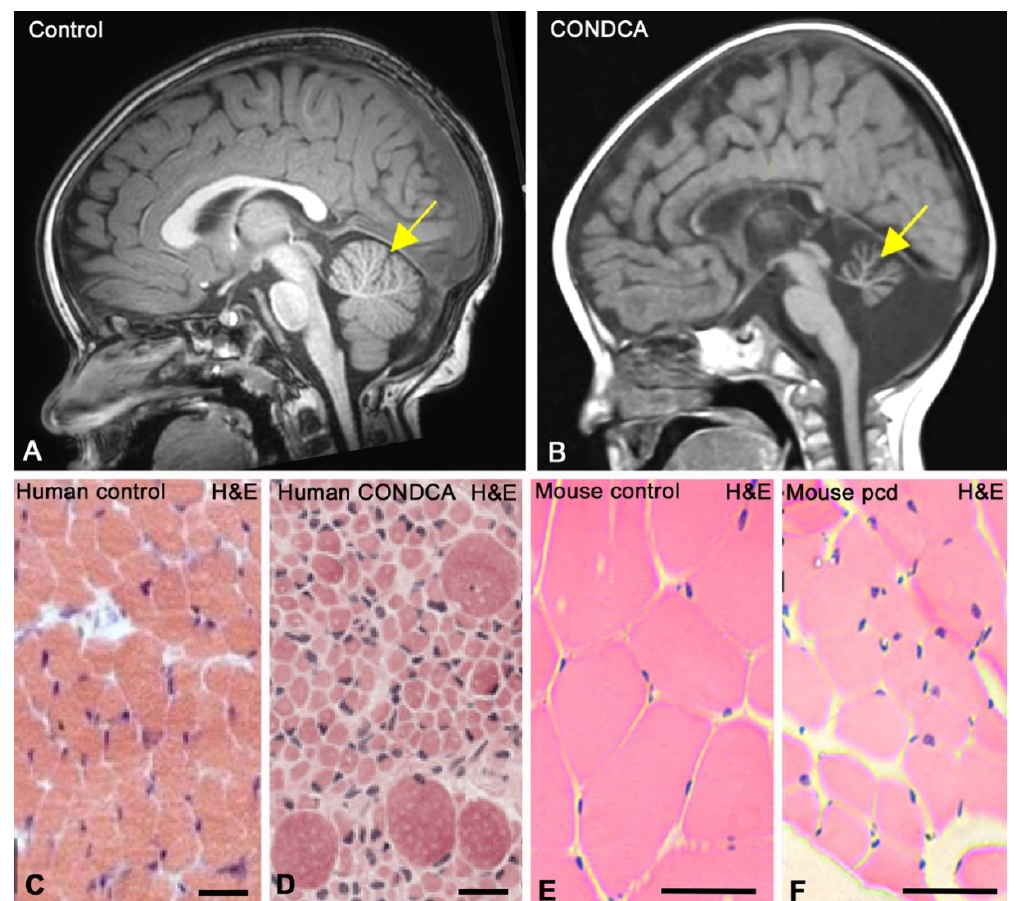
Figure 3. Cranial magnetic resonance imaging (MRI) of a control ( A ) and a CONDCA patient ( B ). Whereas the 20-month-old female healthy control patient ( A ) shows a typical well-developed cerebellum (yellow arrow), severe cerebellar atrophy (yellow arrow) is observed in the 24-month-old female CONDCA patient ( B ). ( A ) Courtesy of Dr. Ana Canga, “Hospital Universitario Marqu é s de Valdecilla”, Santander (Spain). ( B ) Adapted from [3]. Copyright 2019 American Journal of Medical Genetics. ( C , D ) Haematoxylin-eosin (H&E)-stained skeletal muscle tissue biopsies at 7 months of age from healthy control ( C ) and CONDCA patients ( D ). Note the fibre atrophy with a few interspersed hypertrophic fibres in the muscle tissue of the patient. Scale bars: 50 µ m. Adapted with permission from [1]. Copyright 2018 The EMBO Journal. ( E , F ) Haematoxylin-eosin ( E , H )-stained skeletal muscle tissue cross-sections from control ( E ) and pcd ( F ) mice. Note the muscle atrophy and the notable reduction in muscle fibre size in the pcd mouse. Scale bars: 30 µ m. Adapted with permission from [37]. Copyright 2018 Journal of Tissue Engineering and Regenerative